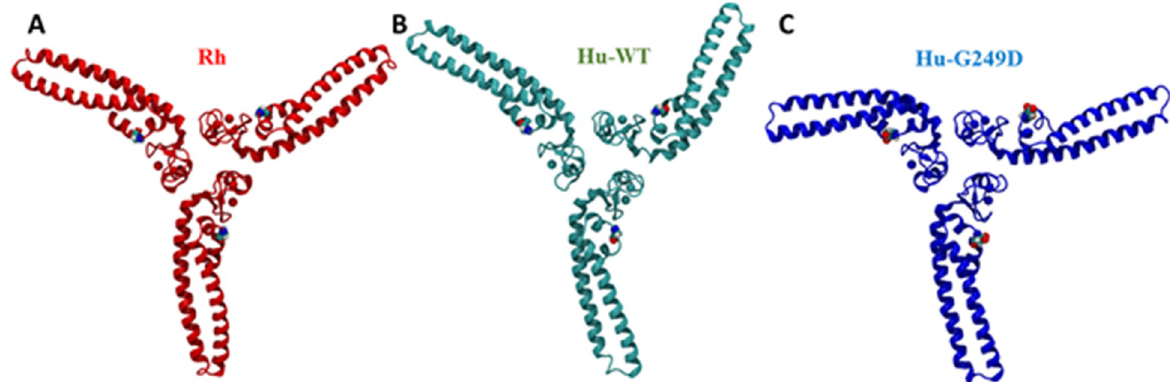
Fig 7. Representative structures of Human WT and G249D Bcc miniTRIM oligomers by MD simulations showing distortions in G249D miniTRIM. We used Bcc miniTRIM structures starting geometries for our homology models and obtained MD simulations with trajectories showing distortions in three-fold symmetry. (A) Rhesus Bcc miniTRIM (in red) (B) Human WT Bcc miniTRIM (in cyan) (C) Human G249D Bcc miniTRIM (in blue).